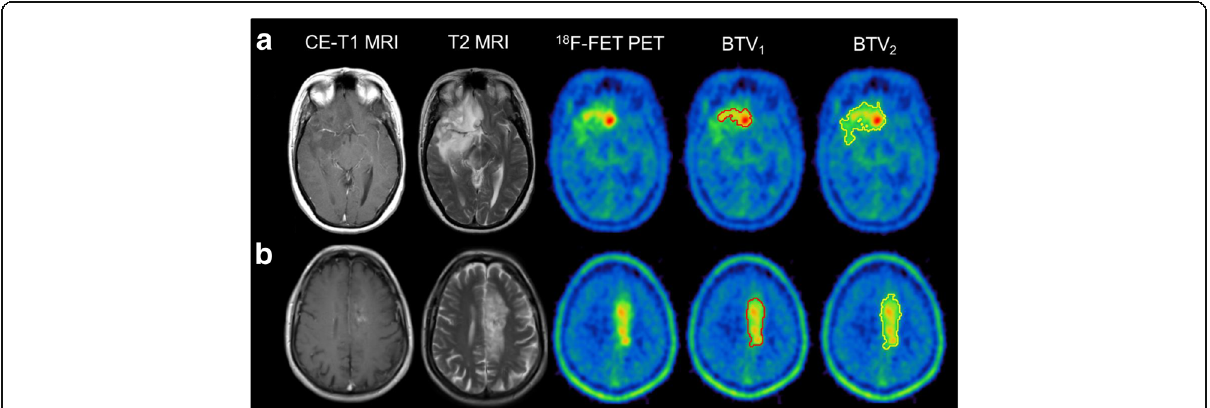
Fig. 4 Influence of different background activity values on TBR max and BTV values. a An example of a simple 2D-ROI assessment with measured background SUV values between 1.17 – 1.50: the resulting TBR max ranges between 3.10 and 4.01 ( Δ TBR max , 0.91; % Δ TBR, 29%), the BTV delineated with the calculated lowest threshold of SUV 1.87 is 45.89 ml, while BTV using the threshold with the highest background SUV (threshold SUV 2.40) results in a BTV with 9.91 ml only ( Δ BTV, 35.98 ml; % Δ BTV, 78%). b The guided VOI assessment with a maximal background SUV range of 0.83 – 0.87 results in a small TBR range of 2.99 – 3.13 ( Δ TBR max , 0.14; % Δ TBR max , 4%) and a BTV range of 20.53 – 22.63 ml ( Δ BTV, 2.10 ml; % Δ BTV,